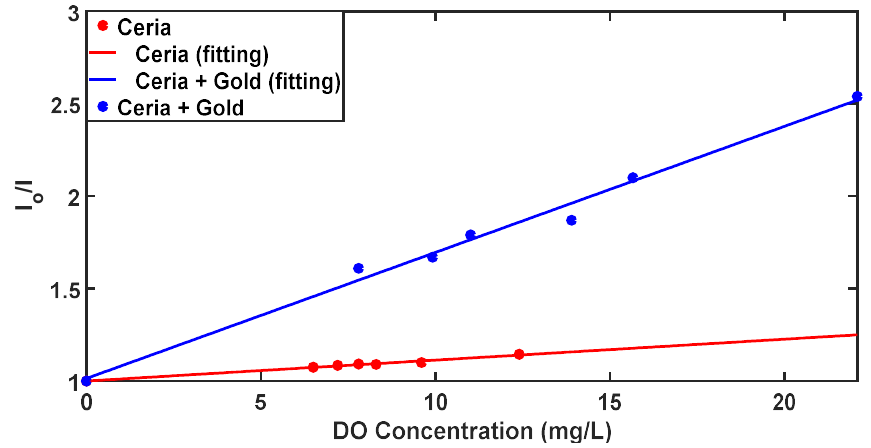
Figure 5. Stern–Volmer analysis of DO optical detection using ceria NPs and gold-ceria NPs.